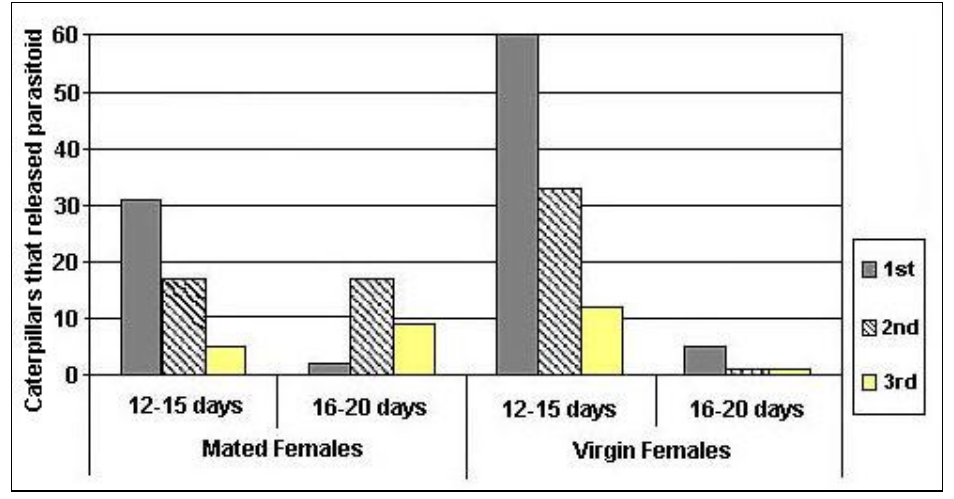
Figure 1: Number of 4 th instar caterpillars of Diatraea saccharalis parasitized in the 1 st , 2 nd or 3 rd oviposition of mated and virgin Cotesia flavipes females that released parasitoids in different